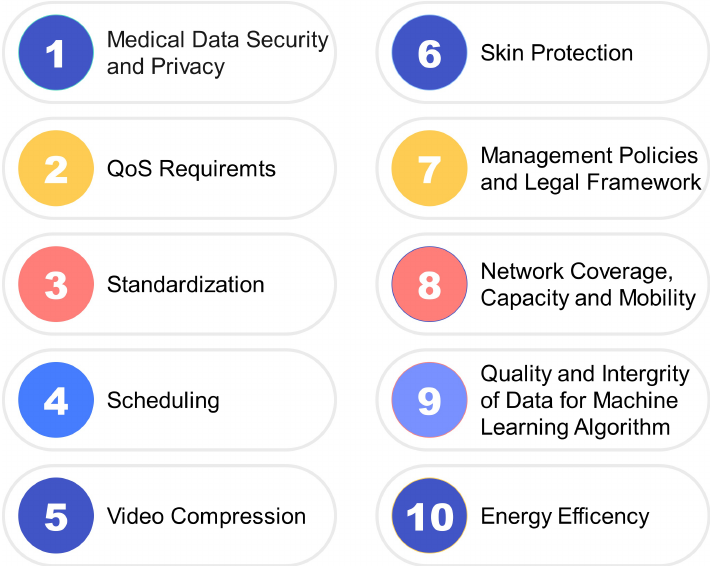
Figure 13. Research Challenges in